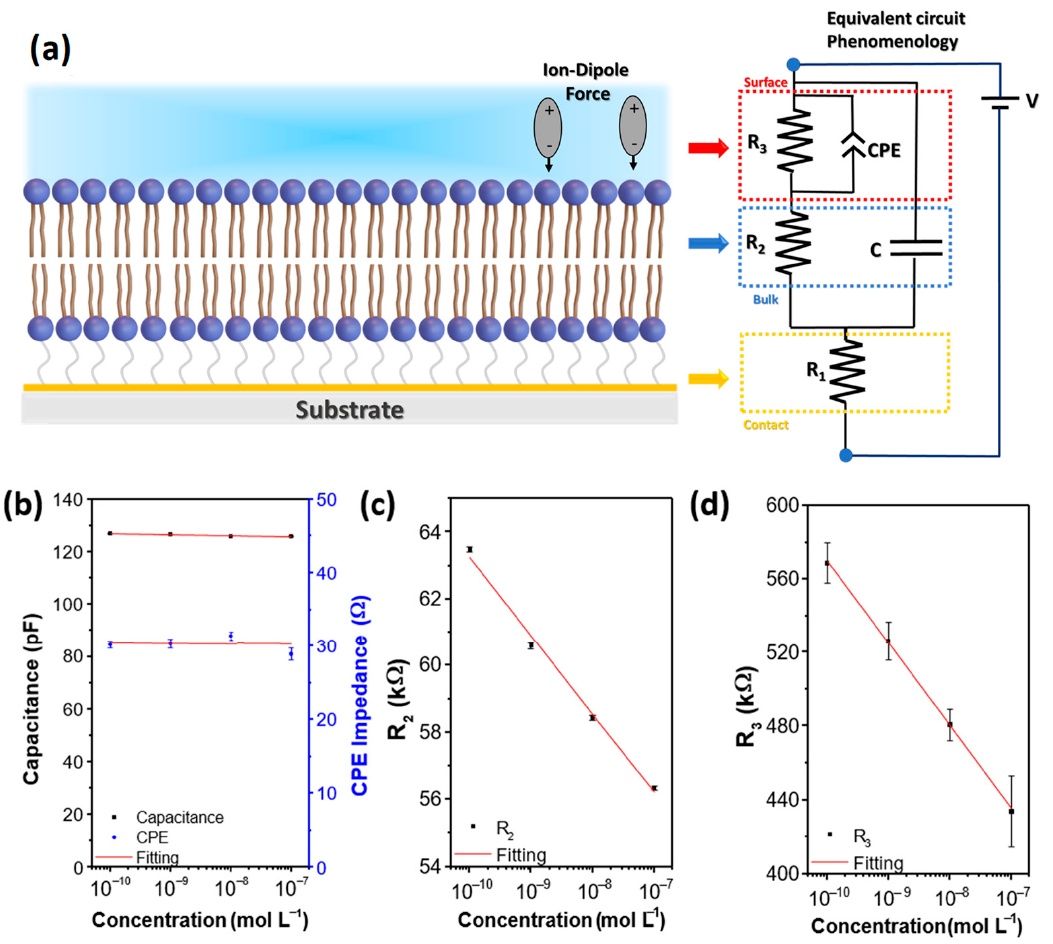
Figure 5. ( a ) Schematic representation of the (DODAB/NiTsPc) 5 LbL film onto gold electrodes together with its corresponding equivalent circuit indicating the phenomenological relationship of the two schemes through arrows. ( b ) C 1 and CPE impedance of CPE versus MBC concentration. ( c ) R 2 versus MBC concentration. ( d ) R 3 versus MBC concentration. The respective errors found in the fit- ting were added as an error bar in the figures. IDE 10.